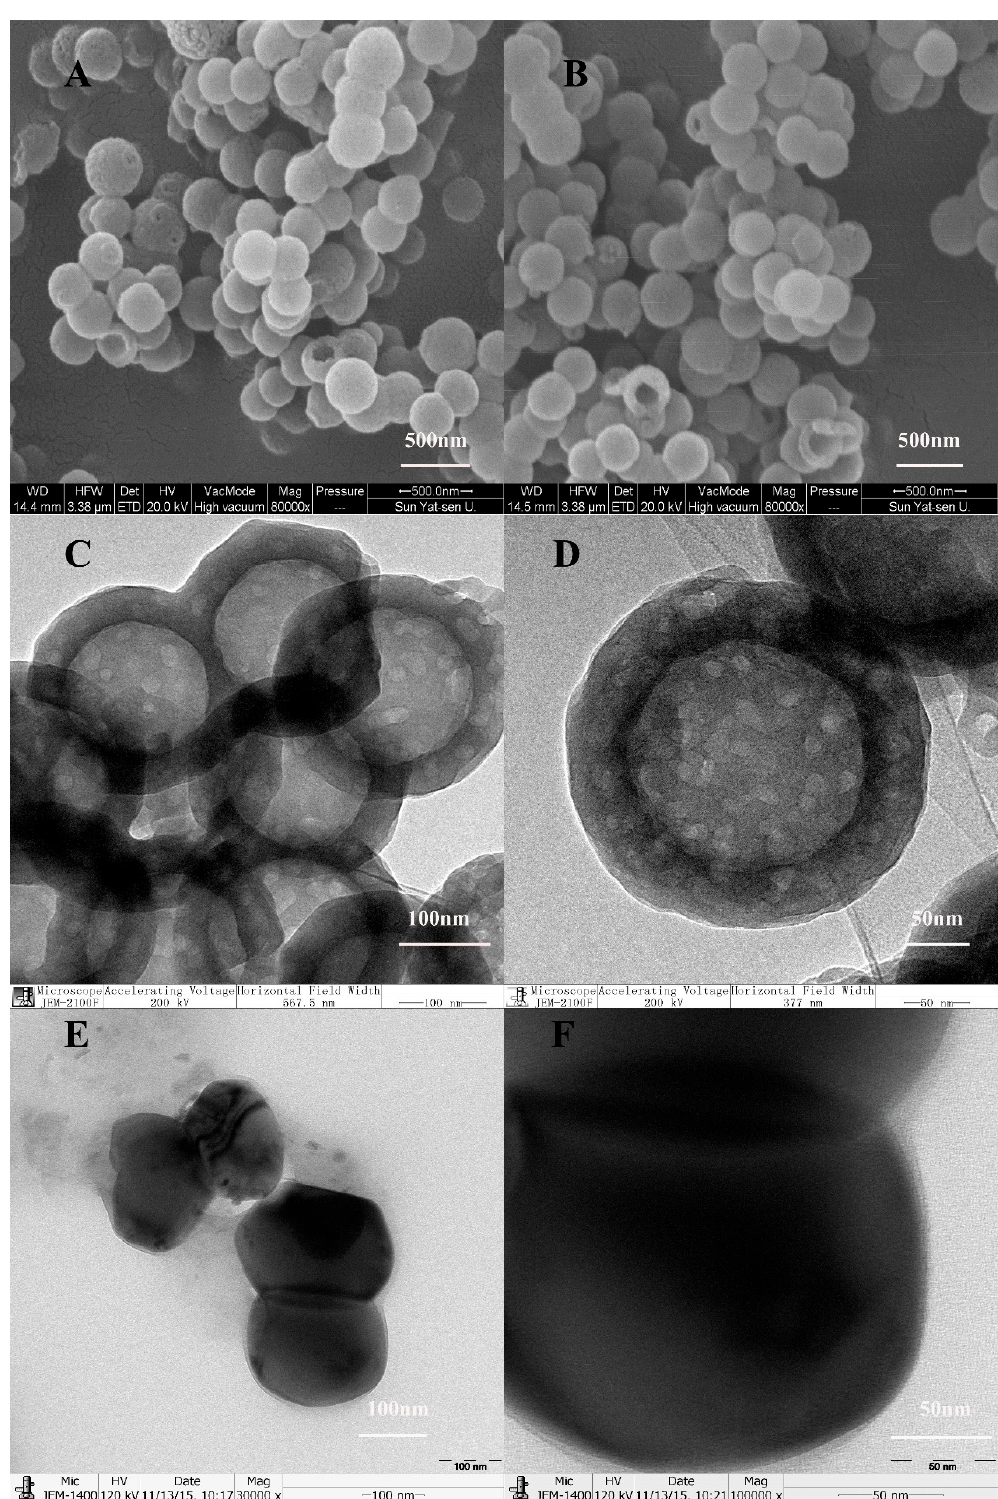
Figure 1. The morphology of nanoparticles. ( A , B ): SEM images of HMSNs; ( C , D ): TEM images of HMSNs; ( E , F ): TEM images of as-synthesized HMSNs without removing the template.